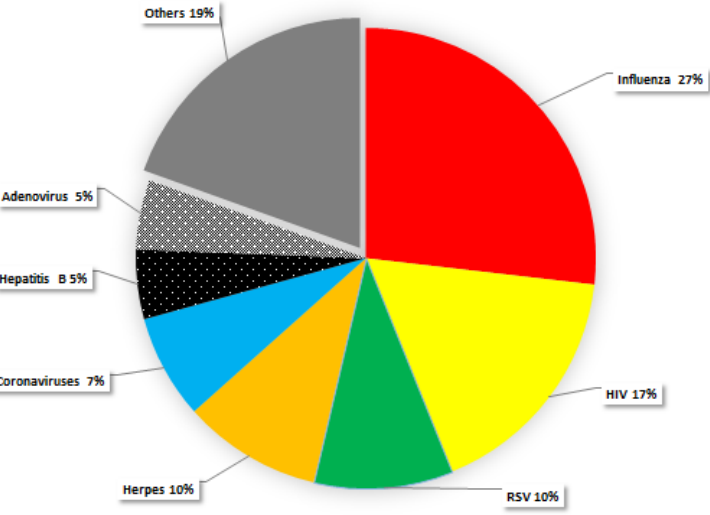
Figure 3. Studies published with all types of POMs on different types of viruses (influenza, HIV, corona, herpes).